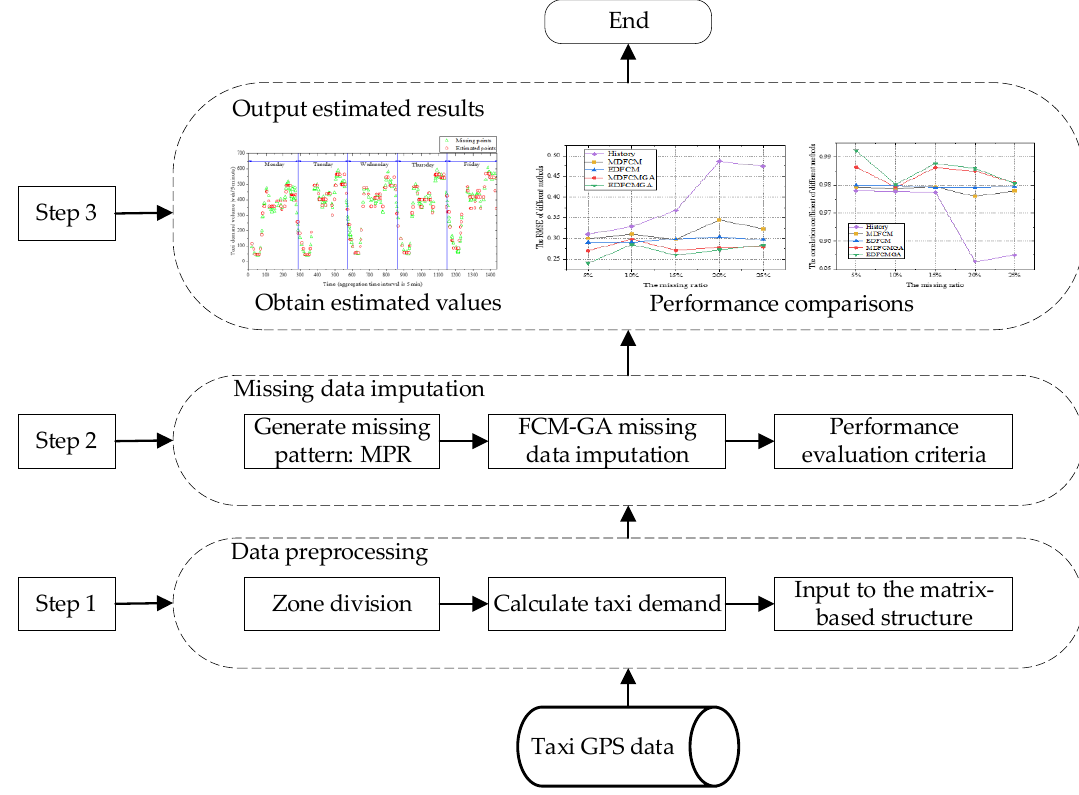
Figure 2. Workflow of the research framework. MPR means missing partially at random; FCM-GA means fuzzy C-means with genetic algorithm.